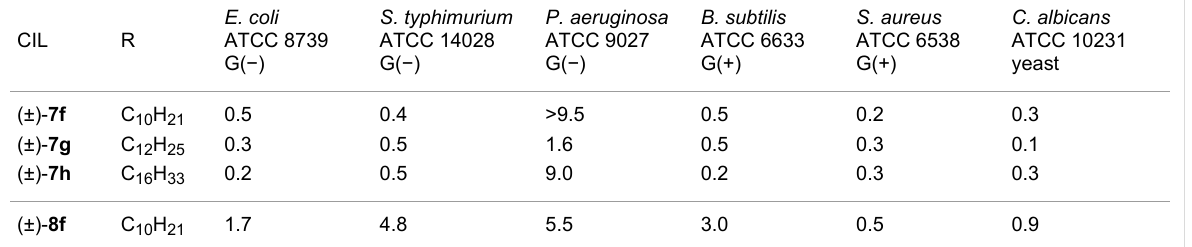
Table 5: The MIC (mM) values for the racemic imidazolium and triazolium CILs. E. coli CIL R ATCC